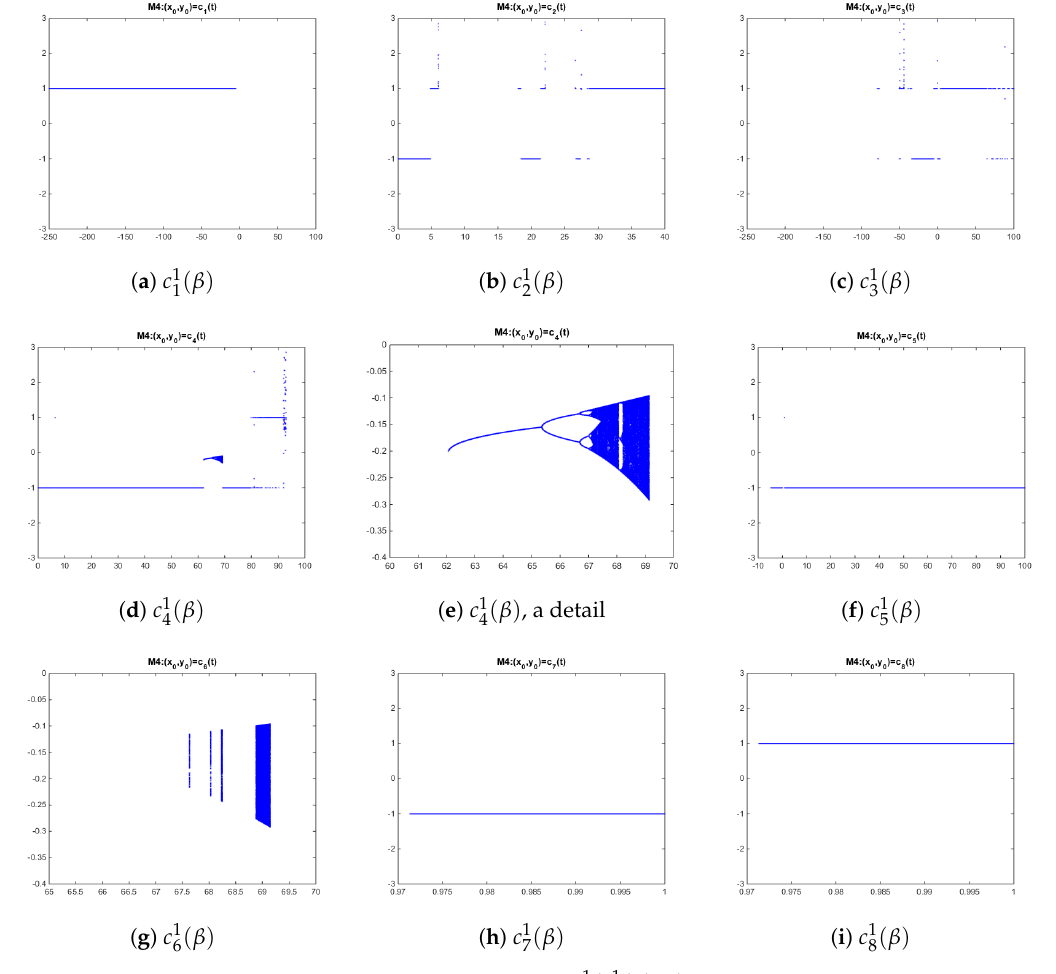
Figure 2. Feigenbaum diagrams of M 1